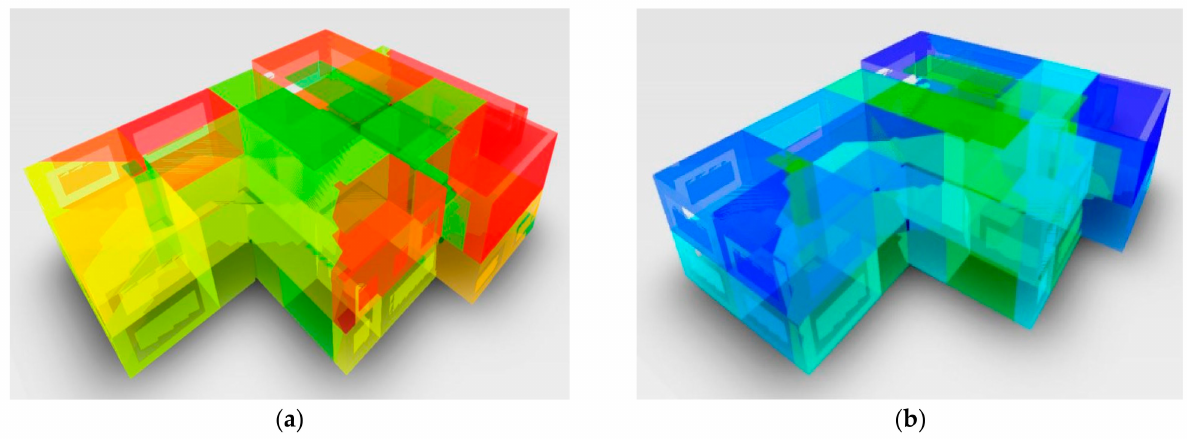
Figure 5. Insight energy analysis for house building. ( a ) Cooling load analysis; ( b ) Heating load analysis.